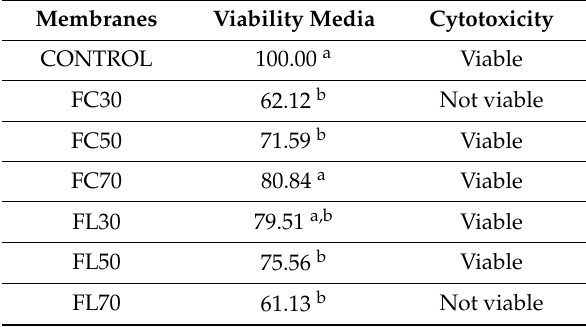
Table 3. Average cytotoxic evaluations of the mixtures using the Sulphordamine B (SRB) method.